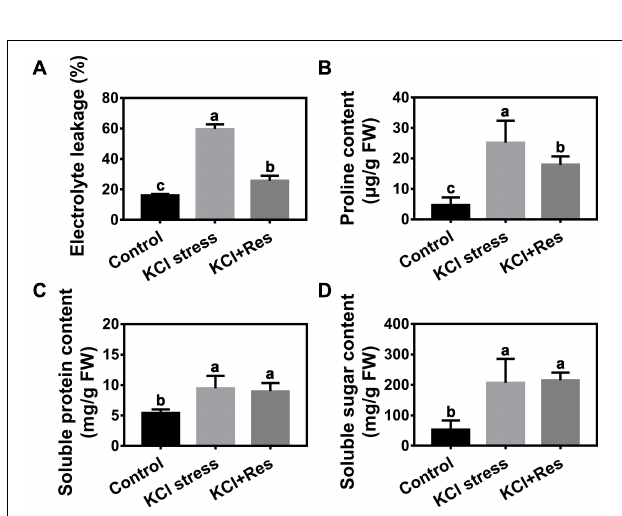
FIGURE 4 | Effects of Res treatment on electrolyte leakage (A) , proline content (B) , soluble protein content (C) , and soluble sugar content (D) under KCl stress. The data represent the mean ± SD of biological replicates. Different lowercase letters indicate significant differences according to Fisher’s least significant difference ( P <